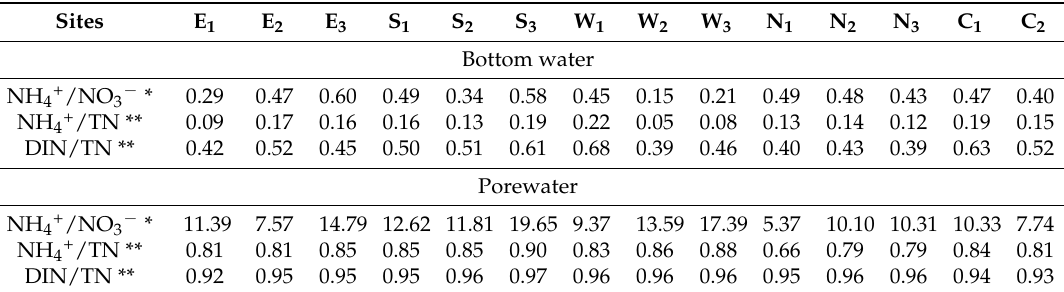
Table A1. Average percentages of total nitrogen (TN) consisting NH 4+ -N and dissolved inorganic nitrogen (DIN) and ratios of NH 4+ -N to NO 3 − -N in bottom surface water and porewater in the hyporheic zone at 14 sampling sites in Lake Taihu during